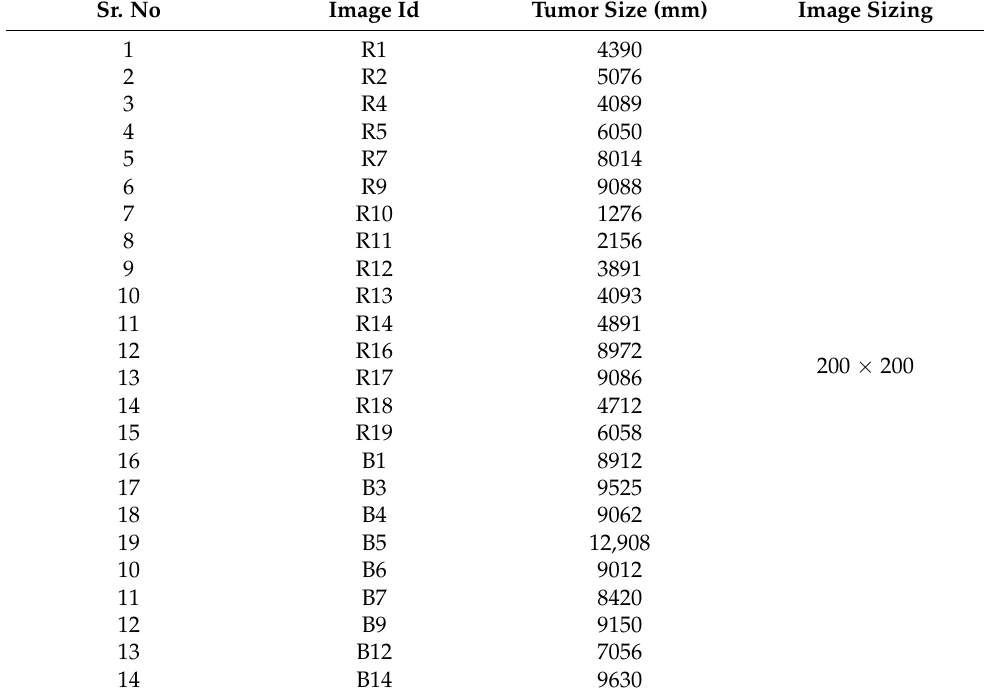
Table 3. Tumor size calculation.